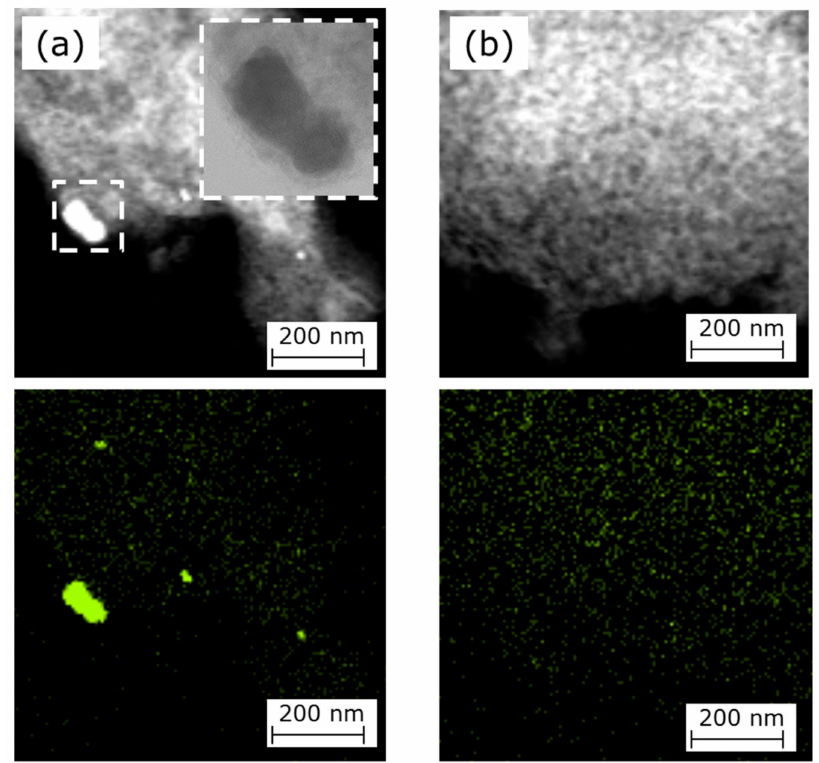
Figure 4. HAADF-STEM images and EDS mapping images of Fe, ( a ) NCB and ( b )